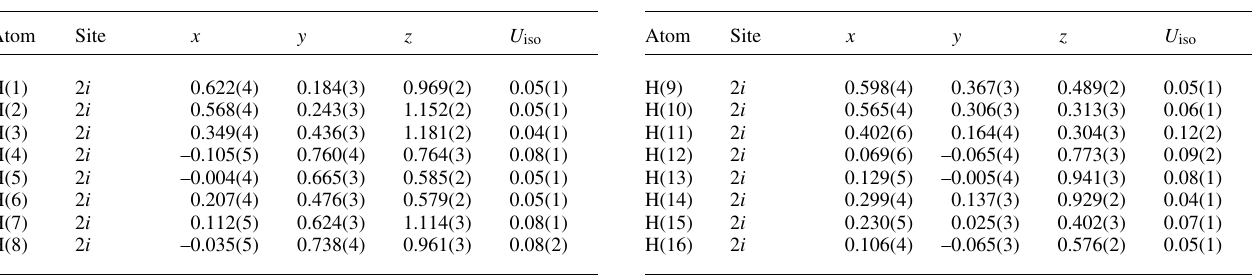
Table 2. Atomic coordinates and displacement parameters (in Å 2 )